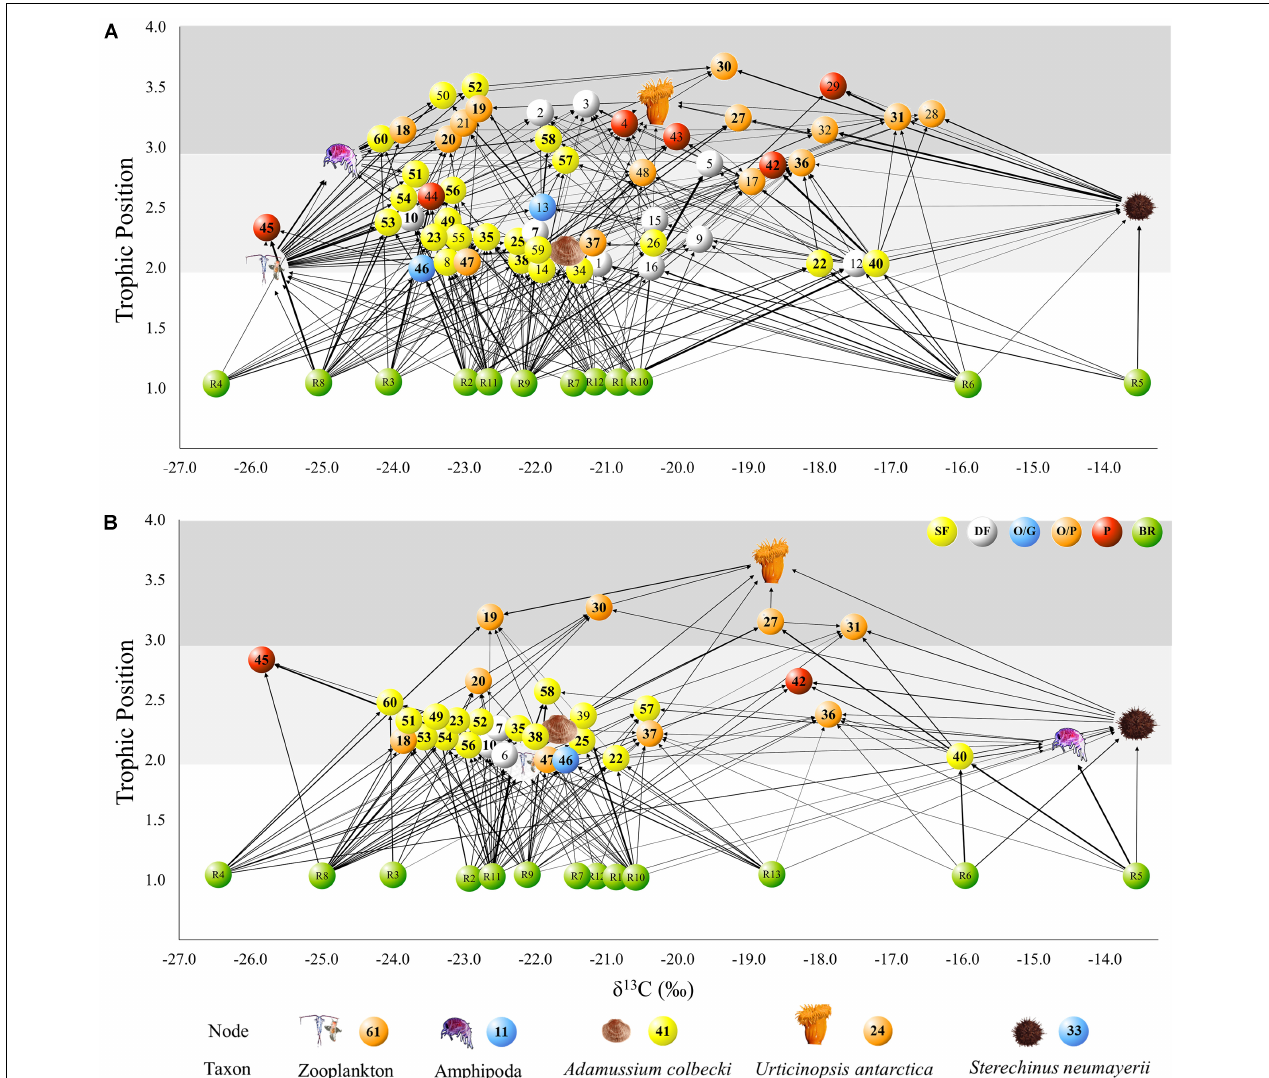
FIGURE 4 | Benthic food web structure in Tethys Bay, Terra Nova Bay (Ross Sea): BEFORE (A) and AFTER (B) . Each node represents one taxon in the community. Arrows point from a resource to its consumer and their thickness is proportional to the linkage strength. The position of each node represents its δ 13 C and Trophic Position (TP). Colors indicate the dominant feeding mode of each taxon: yellow: suspension feeder; white: deposit feeder; blue: omnivorous/grazer; orange: omnivorous/predator; red: predator. Basal resources are shown in green. The food web graphs were developed using Cytoscape software. Bold IDs indicate taxa sampled in both study periods. For the list of taxa please refer to Table 1